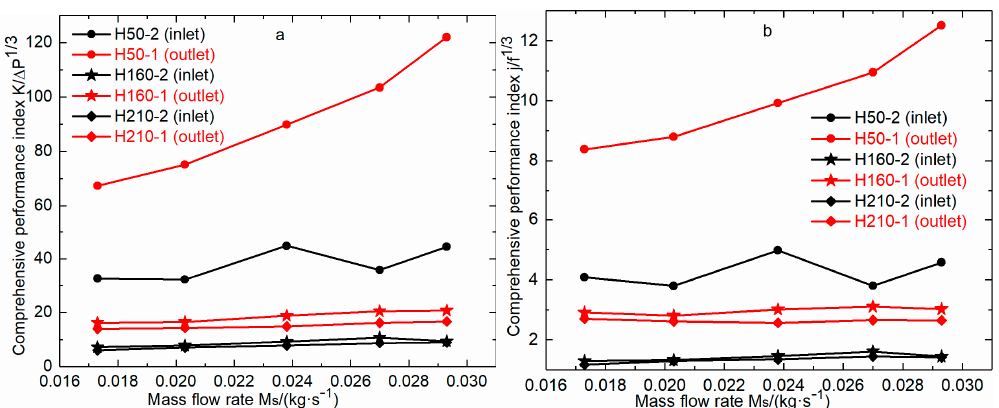
(cid:3117) (cid:3117) (cid:3119) ⁄ versus mass flow rate ( b ) comprehensive (cid:3119) ⁄ versus mass flow rate ( b ) comprehensive